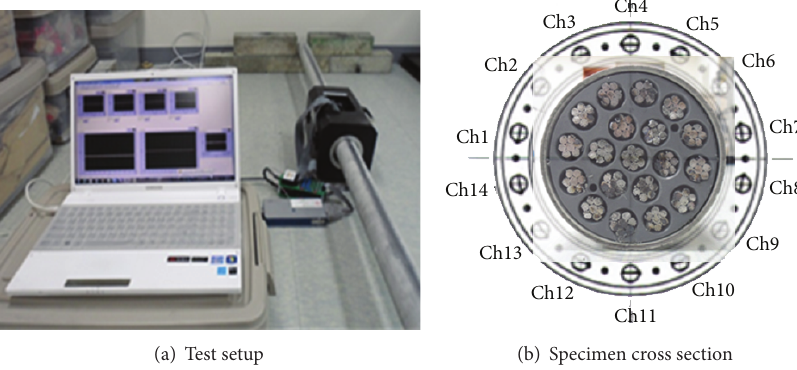
Figure 22: Laboratory tests of the magnetic sensor performance. Table 3: Parameters used in the image-processing